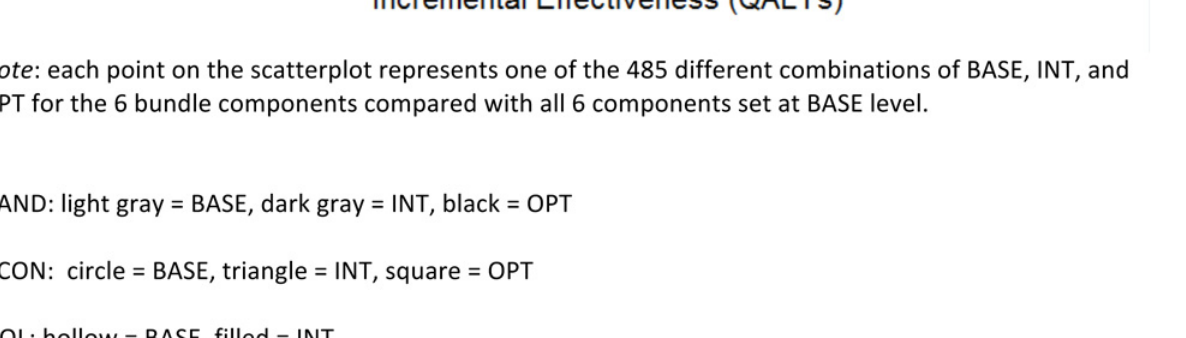
Fig 1. Scatterplot of incremental cost and effectiveness ( C . difficile infections averted) of intervention strategies compared with BASE levels of all 6 bundle components. HAND: light gray = BASE, dark gray = INT, black = OPT; DCON: circle = BASE, triangle = INT, square = OPT; ISOL: hollow = BASE, filled =